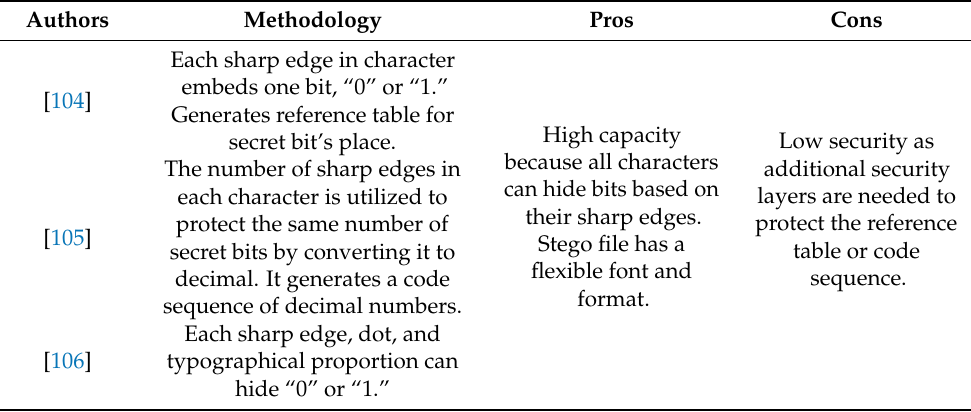
Table 16. A summary of the reviewed article on the sharp edges approach.